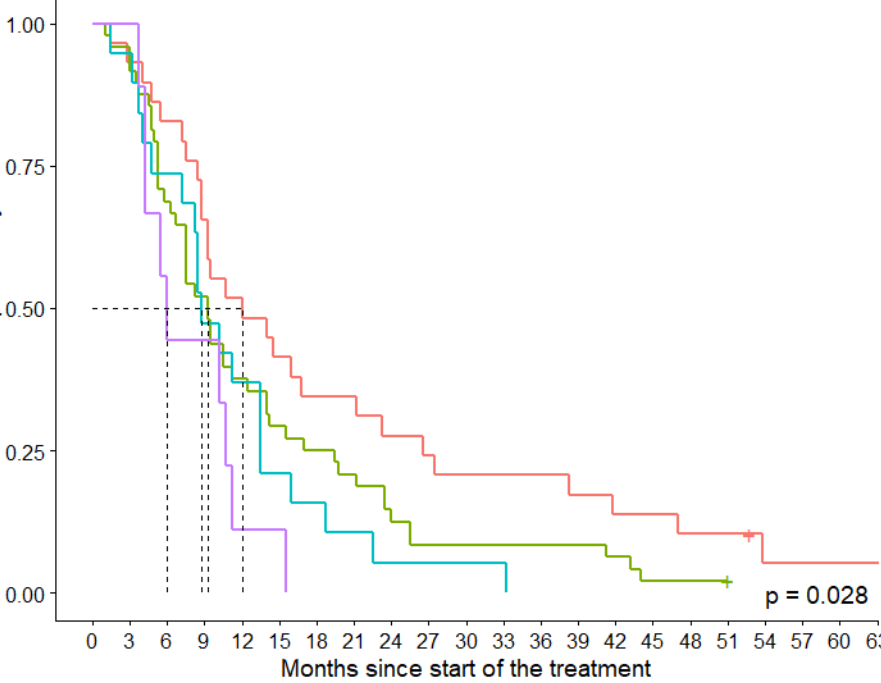
Figure 4. Kaplan–Meier curves for groups based on baseline platelet level and platelet